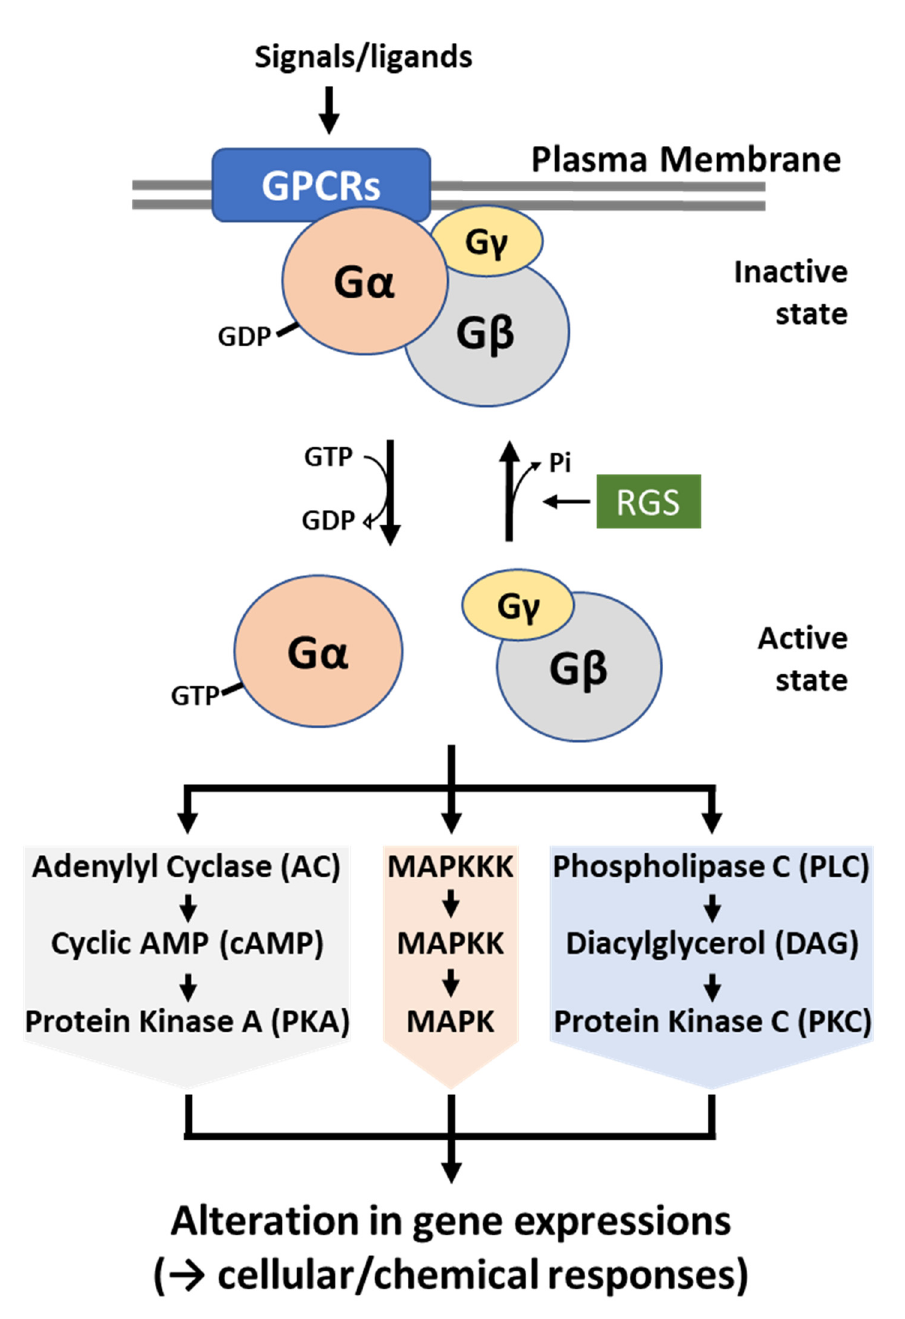
Figure 2. A schematic diagram of heterotrimeric G protein-mediated signaling pathway. Upon the recognition of external ligands, a G protein-coupled receptor (GPCR) is sensitized and interacts with a nearby G protein. Then, G proteins become active by the interaction with GTP and initiate downstream signaling pathway(s): PKA, MAPK, and PKC. This signal transduction results in the differential expression of genes involved in growth, development, morphogenesis, mating, metabolism, virulence, and mycotoxin biosynthesis. The activated G proteins are then negatively controlled by regulators of G protein signaling (RGS) and become inactive again.